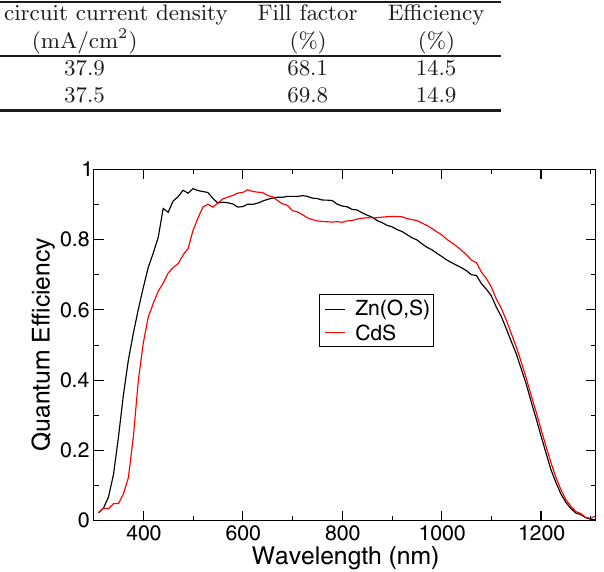
Fig. 6. Quantum efficiencies of CIGSSe/Zn(O, S)/ZnO:Al and CIGSSe/CdS/ZnO/ZnO:Al solar